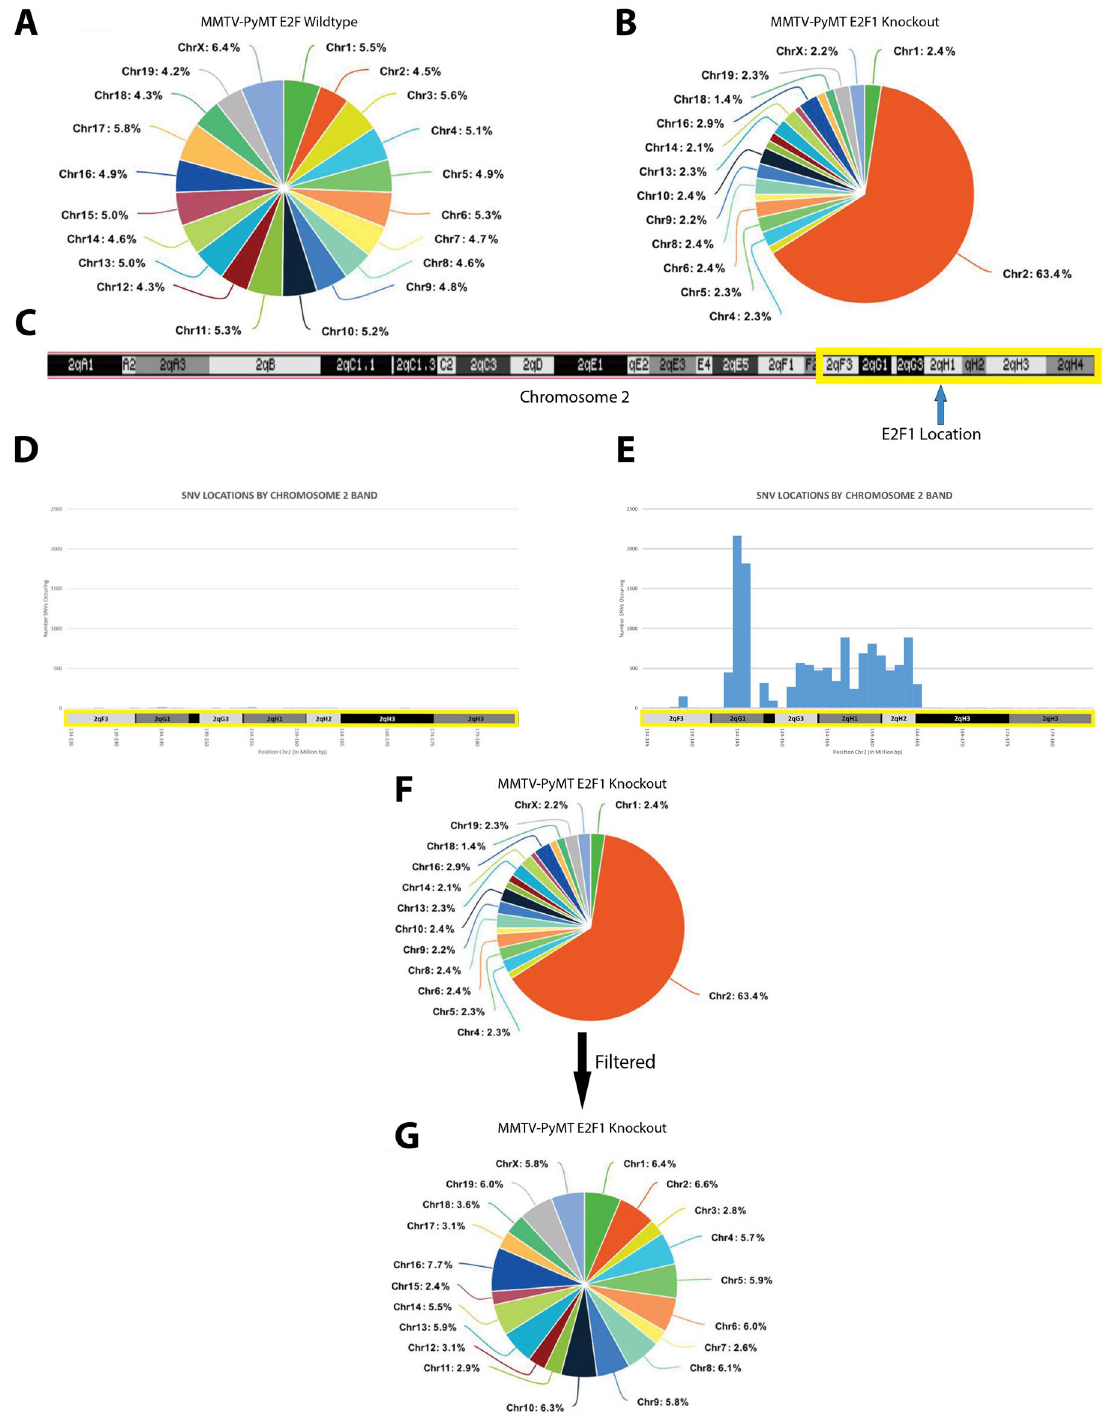
Figure 3. Filtering background strain to remove artifacts that have potential to confound analysis. ( A ) Pie chart from an E2F1 +/+ PyMT tumor represents the normalized (SNVs/chromosome size) percentage of SNVs within each chromosome. ( B ) Pie chart from an E2F1 −/− PyMT tumor represents the normalized percentage of SNVs within each chromosome. An abundance of SNVs within chromosome 2 is observed. ( C ) The banding pattern of mouse chromosome 2. The arrow highlights the location of E2F1, and the yellow box represents the bands represented in ( D ) and ( E ). ( D ) Manhattan plot shows the number of SNVs occurring within the 2qF3–2qH3 bands of chromosome 2, in the E2F1 +/+ sample from ( A ). ( E ) Manhattan plot shows the number of SNVs occurring within the 2qF3–2qH3 bands of chromosome 2, in the E2F1 −/− sample from ( B ). ( F ) Top pie chart is the same as in ( B ). Bottom pie chart represents the percentage of SNVs across each chromosome of the same sample as above, after filtering on the sv129